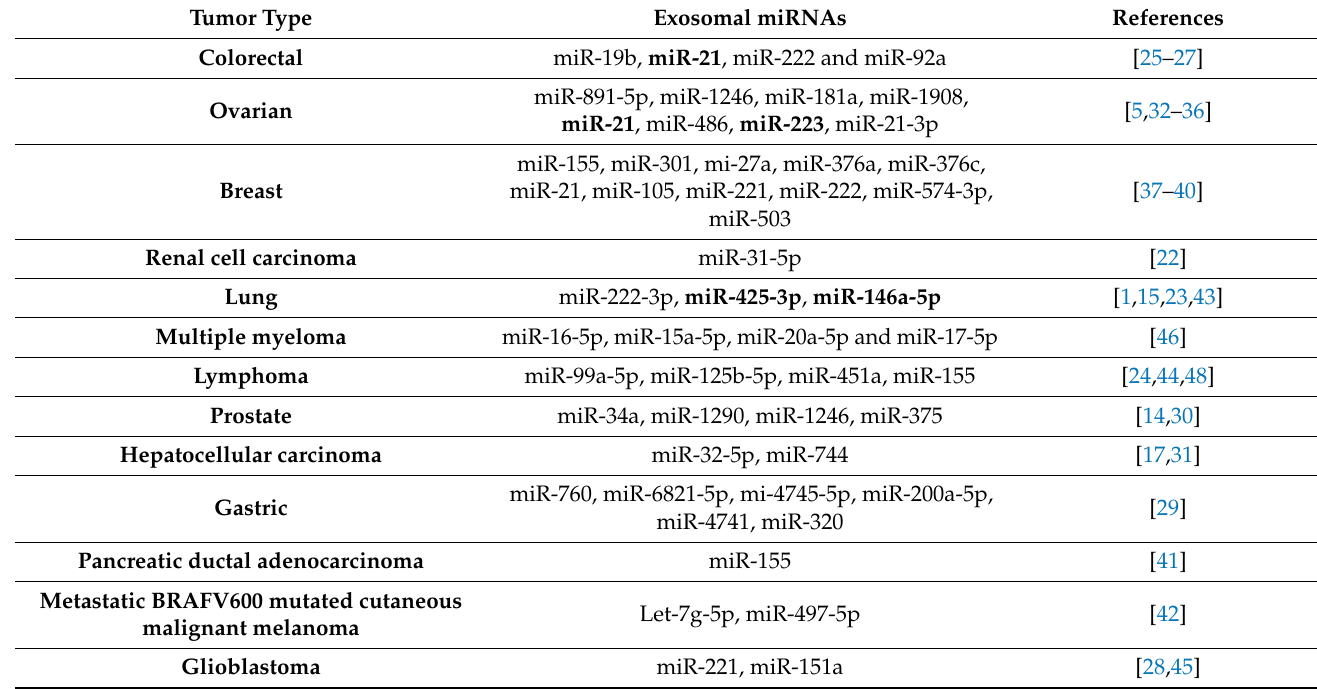
Table 3. List of miRNAs identified in the studies that were included in this systematic review. miRNAs found to be in common among several studies regarding the same type of cancer have been